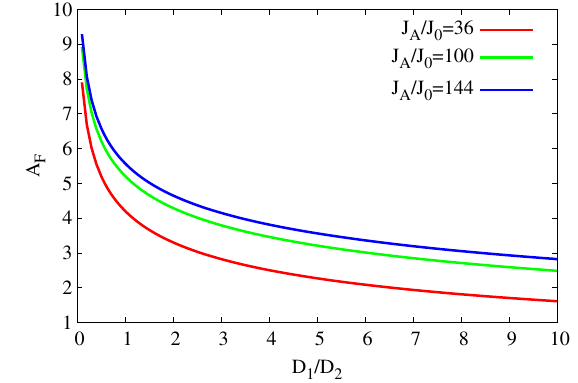
FIG. 10. Dependence of A F , defined in Eq. (38), on the ratio of diffusion coefficients D 1 =D 2 for three values of the ratio of the action at the absorbing aperture J A to the initial emittance J 0